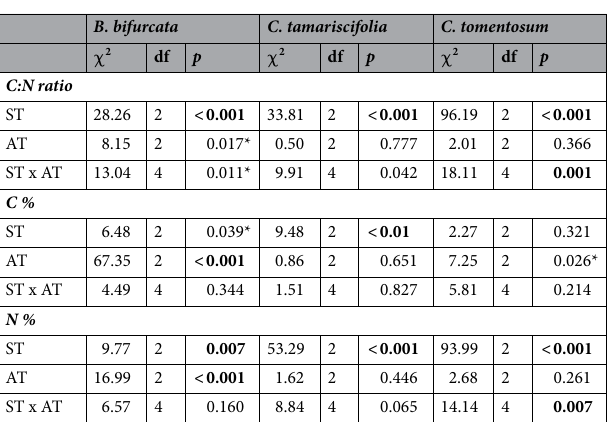
Figure 5. C:N ratio as a function of seawater temperature treatments (control ~ 18.3 °C, marine heatwave ~ 19.9 °C and extreme marine heatwave ~ 22.3 °C) in fronds exposed to control (~ 23.2 °C), atmospheric heatwave (~ 32.7 °C) and extreme atmospheric heatwave (~ 35.7 °C) air temperatures during emersion. The points are the replicates and the smoothed curves are the data fitted by GLMs with a confidence interval of 95%.